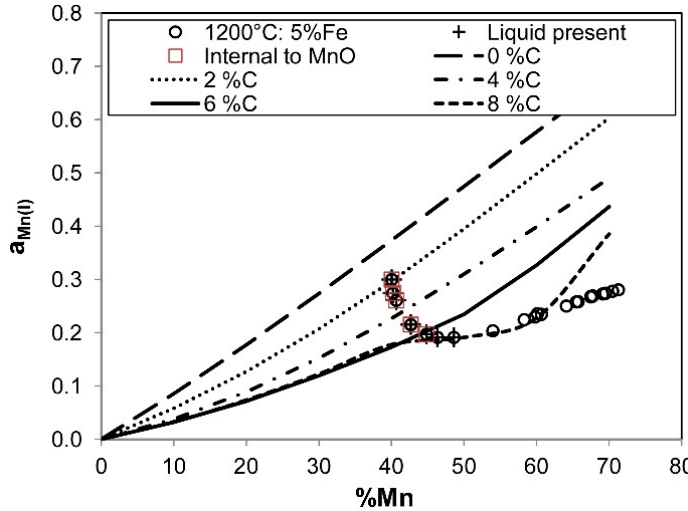
Figure 10. Mn activity vs. %Mn in Sample C (1200 °C, 15% Fe).